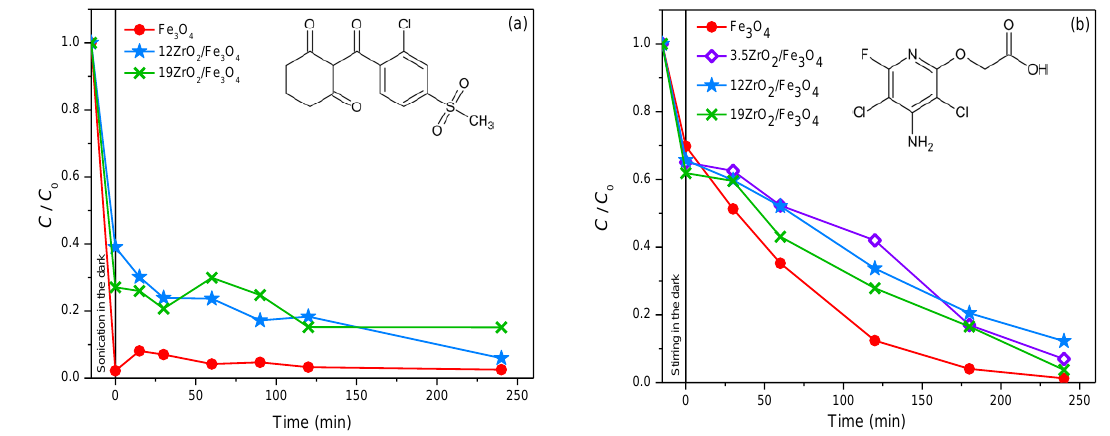
Figure 8. ( a ) Kinetics of removal of sulcotrione (0.05 mmol/dm 3 ) at pH 2.8 in the presence of Fe 3 O 4 , 12ZrO 2 /Fe 3 O 4 and 19ZrO 2 /Fe 3 O 4 (1.0 mg/cm 3 ) with 45 mmol/dm 3 H 2 O 2 and using solar irradiation. Inset represents the structural formula of sulcotrione. ( b ) Effect of stirring the suspension before irradiation on the adsorption and degradation kinetics of fluroxypyr (0.05 mmol/dm 3 ) using Fe 3 O 4 and different ZrO 2 /Fe 3 O 4 nanopowders in the presence of H 2 O 2 (3.0 mmol/dm 3 ) at pH 2.8 and solar irradiation. Inset represents the structural formula of fluroxypyr.